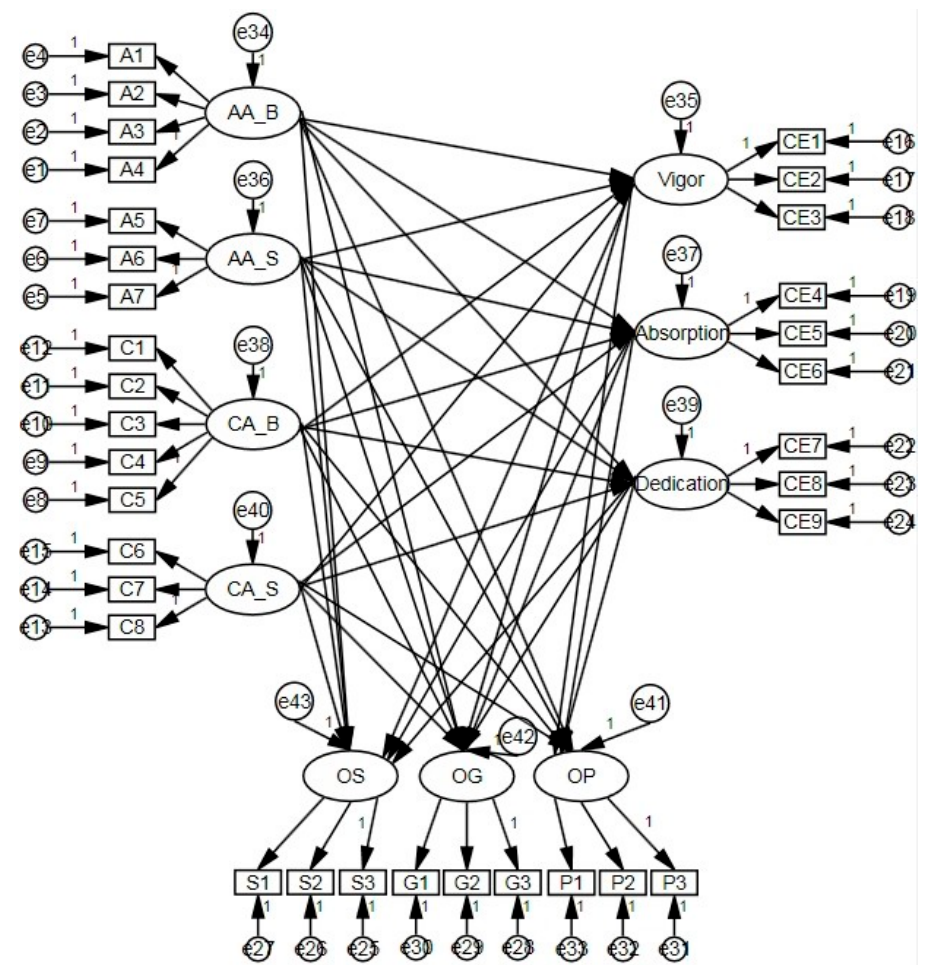
Figure 2. Path diagram of the proposed model.